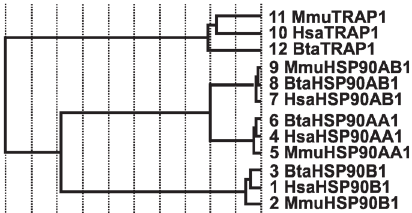
Figure 6. Sequence identity dendrogram of heat shock protein 40 type 1 and 2 gene family members. The first three letters Hsa, Bta and Mmu corresponds to human, bovine and mouse, respectively. The numbers represent the sequence numbers used in the evolutionary trace analysis.